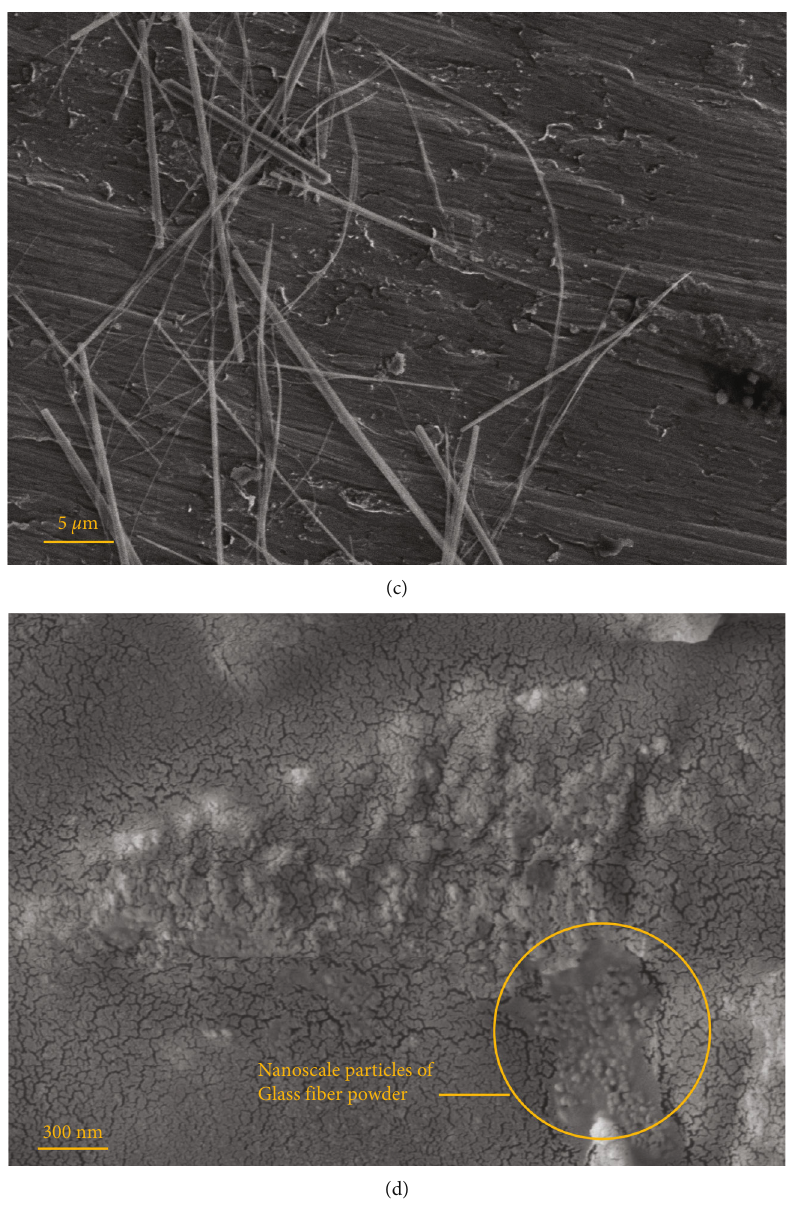
Figure 6: SEM pictures of GF-S (a), GF-L (b), and GF-P (c, d) reinforced